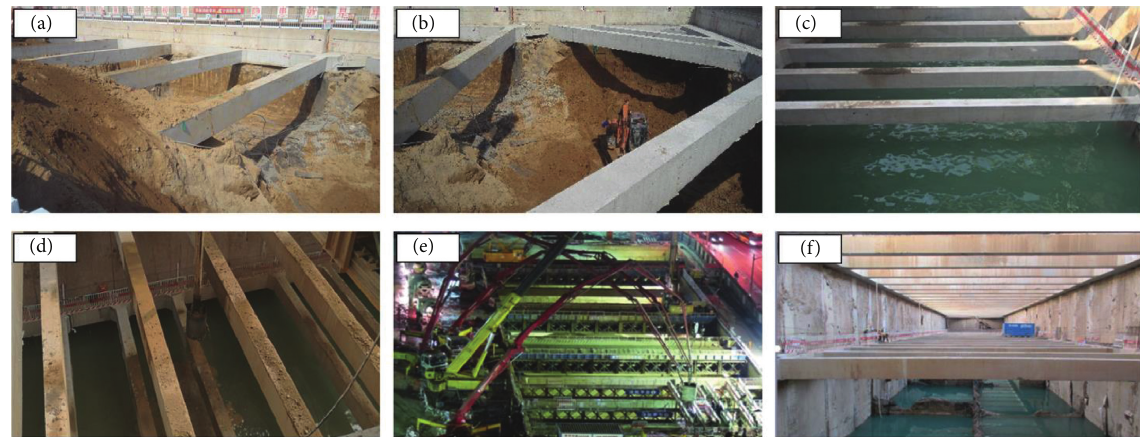
Figure 4: Critical steps during excavation for YDM project. (a) Step 1, (b) step 4, (c) step 5, (d) step 6, (e) step 7, and (f) step 8.